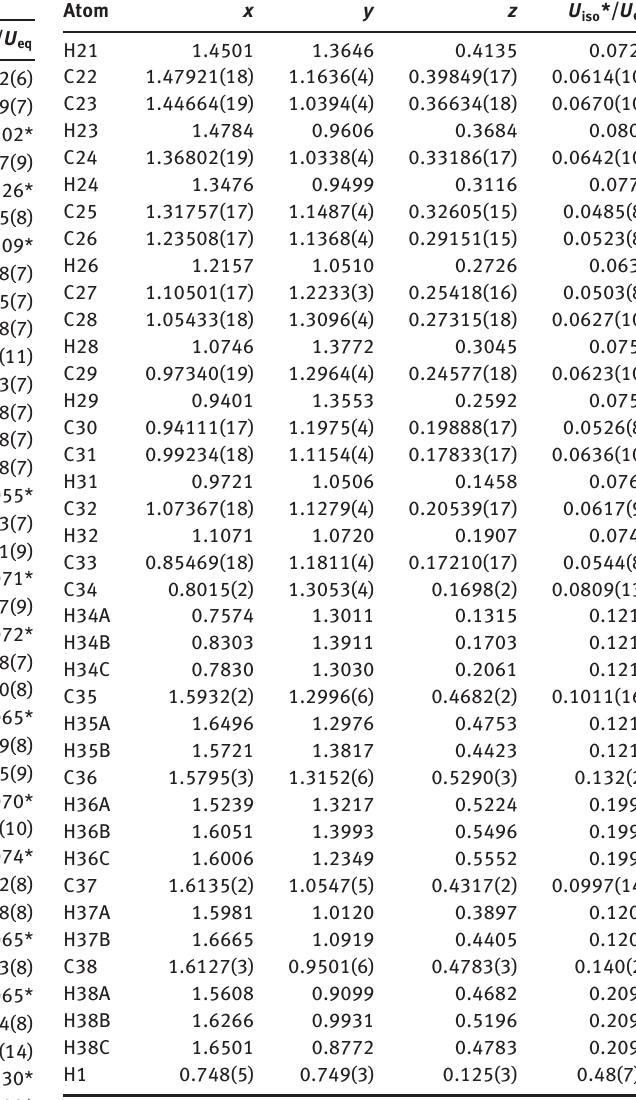
Table 2: Fractional atomic coordinates and isotropic or equivalent isotropic displacement parameters (Å 2